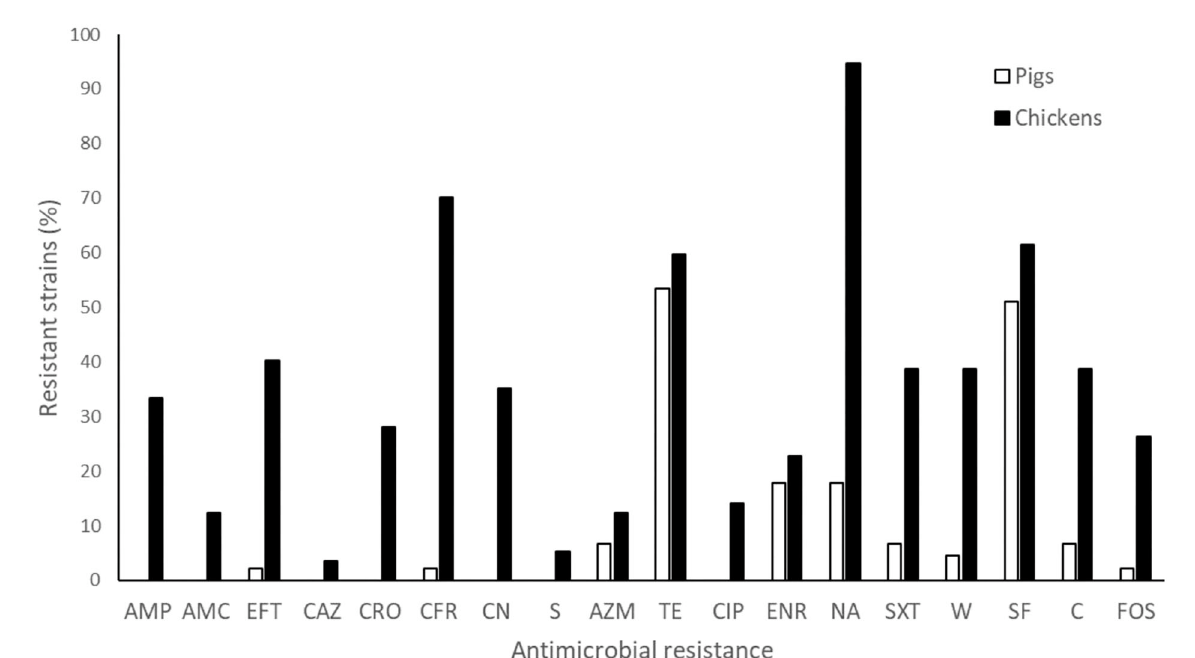
FIGURE3 Phenotypic antimicrobial resistance of S. enterica strains isolated from pigs and chickens against 18 classes of antibiotics. AMP, ampicillin; AMC, amoxicillin + clavulanic acid; CFR, cefadroxil; CAZ, ceftazidime; EFT, ceftiofur; CRO, ceftriaxone; CIP, ciprofloxacin; CN, gentamicin; NA, nalidixic acid; SXT, sulfamethoxazole + trimethoprim; TE, tetracycline; S, streptomycin; AZM, azithromycin; ENR, enrofloxacin; W, trimethoprim; SF, sulfisoxazole; C, chloramphenicol; FOS,